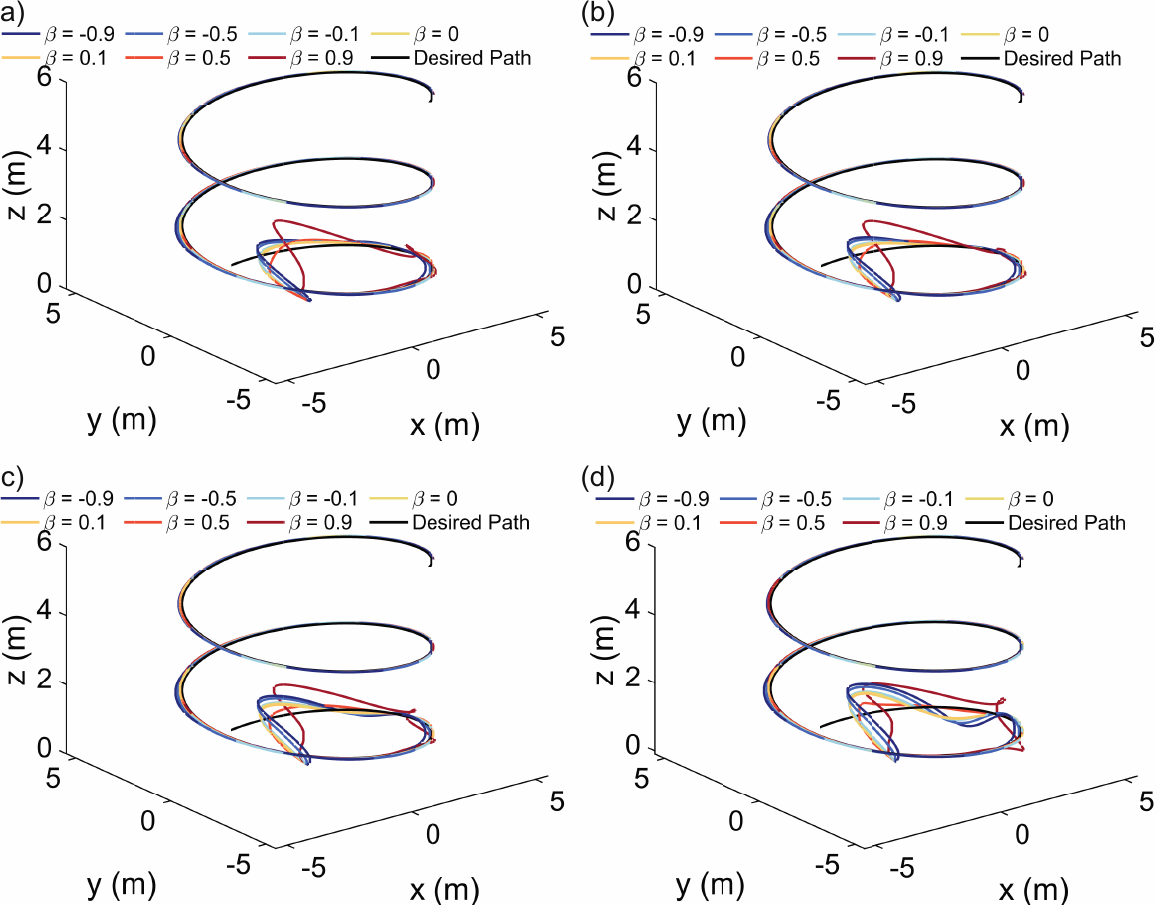
Figure 3. Simulated results that demonstrate the robustness of the varying fractional orders in the proposed controller to uncertainty in the quadrotor dynamics with various payloads: ( a ) d 3 = 0 m/s 2 , ( b ) d 3 = 2 m/s 2 , ( c ) d 3 = 4 m/s 2 , ( d ) d 3 = 6 m/s 2 . (Assume that d 1 = d 2 = d 4 = d 5 = d 6 = 0 and no input time delay.) Table 3. Root mean squared error (RMSE) of the simulated tracks under different payloads and different fractional orders in the proposed controller.